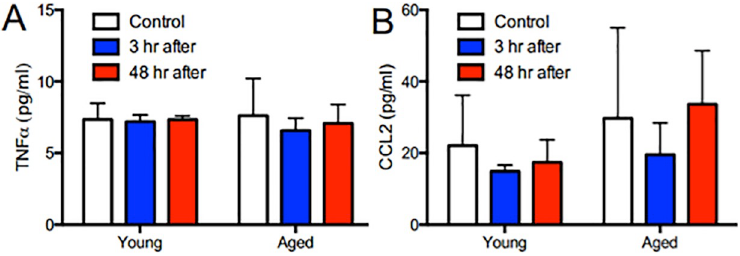
Fig 5. Isoflurane has no effect on plasma TNF α or CCL2 in young or aged mice. Mice were anesthetized as above and TNF α and CCL2 measured in plasma 3 and 48 h later by ELISA. There was no effect of age (p > 0.05), treatment condition (p > 0.05), or any interactions between the two (p > 0.05). Data expressed as mean ± SD for N = 5–6 animals per treatment condition and analyzed using a 2-way